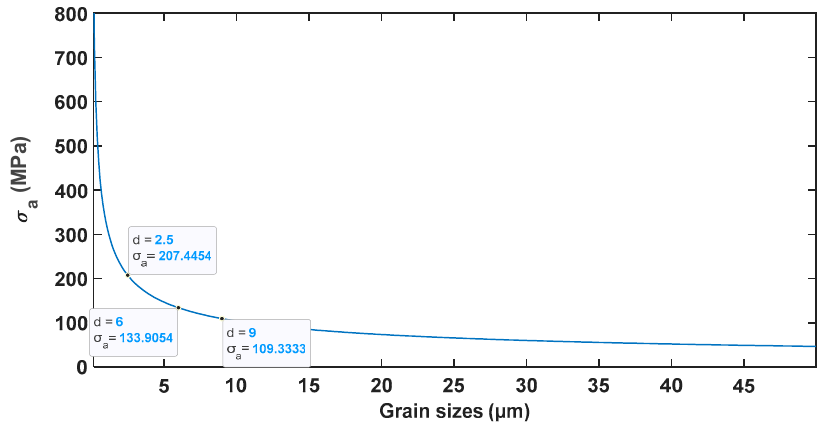
Figure 3. Graphical description of the Hall–Petch relationship for DMLS Ti6Al4V(ELI).